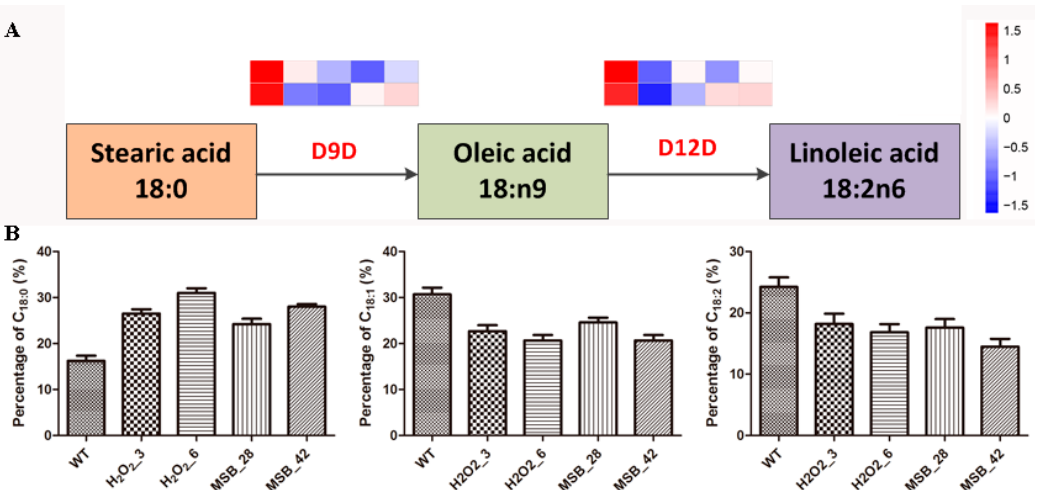
Figure 6. DEGs involved in the linoleic acid biosynthesis pathways and the changes of C18 fatty acid in response to oxidative stress. ( A ) The expression pattern of DEGs involved in the linoleic acid biosynthesis pathways (from left to right: the control, 3 mM and 6 mM H 2 O 2 , 0.28 mM and 0.42 mM MSB); ( B ) The changes of C18 fatty acid in response to oxidative stress. The bars represent the average ( ± SE) of biological repeats. WT: the control; H 2 O 2 : the H 2 O 2 treatments (3 and 6 mM); MSB: the MSB treatments (0.28 and 0.42 mM).